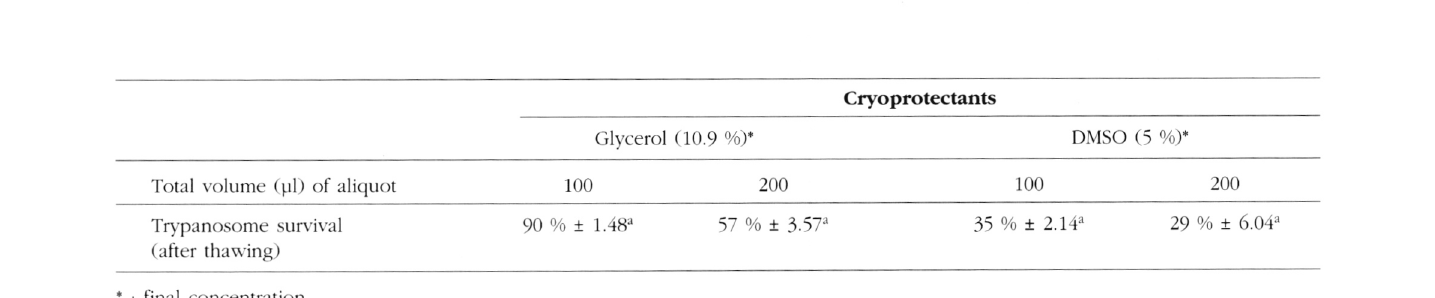
Fig. 2. - Evolution of T. vivax parasitaemia in control rats and rats treated with cyclophosphamide. Parasite burdens were determined from rat blood and are represented as mean + SD for three rats per group. Statistically significant differences between rats groups p < 0.001 (*) and p < 0.01 (**) are indicated. These results are repre­ sentative for three individual experiments performed.